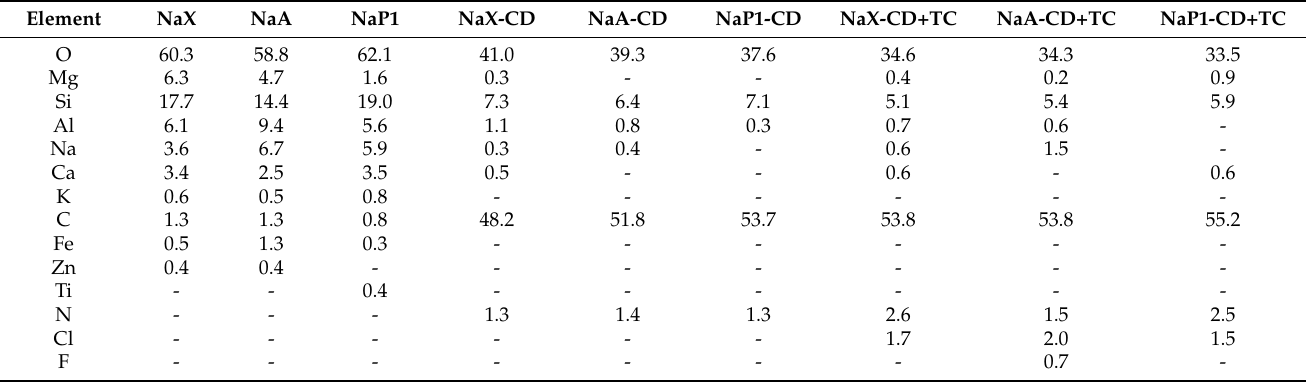
Figure 6. High-resolution C1s spectra of NaX-CD (a), NaX-CD after TC adsorption (b), NaA-CD (c), NaA-CD after TC adsorption (d), NaP1-CD (e), NaP1-CD after TC adsorption (red — experimental curve, blue—fit peak, green—background) ( f ). Table 4. Elemental composition (atomic concentration %) of the surface of the bare zeolites and zeolites modified with β -CD before and after TC adsorption.